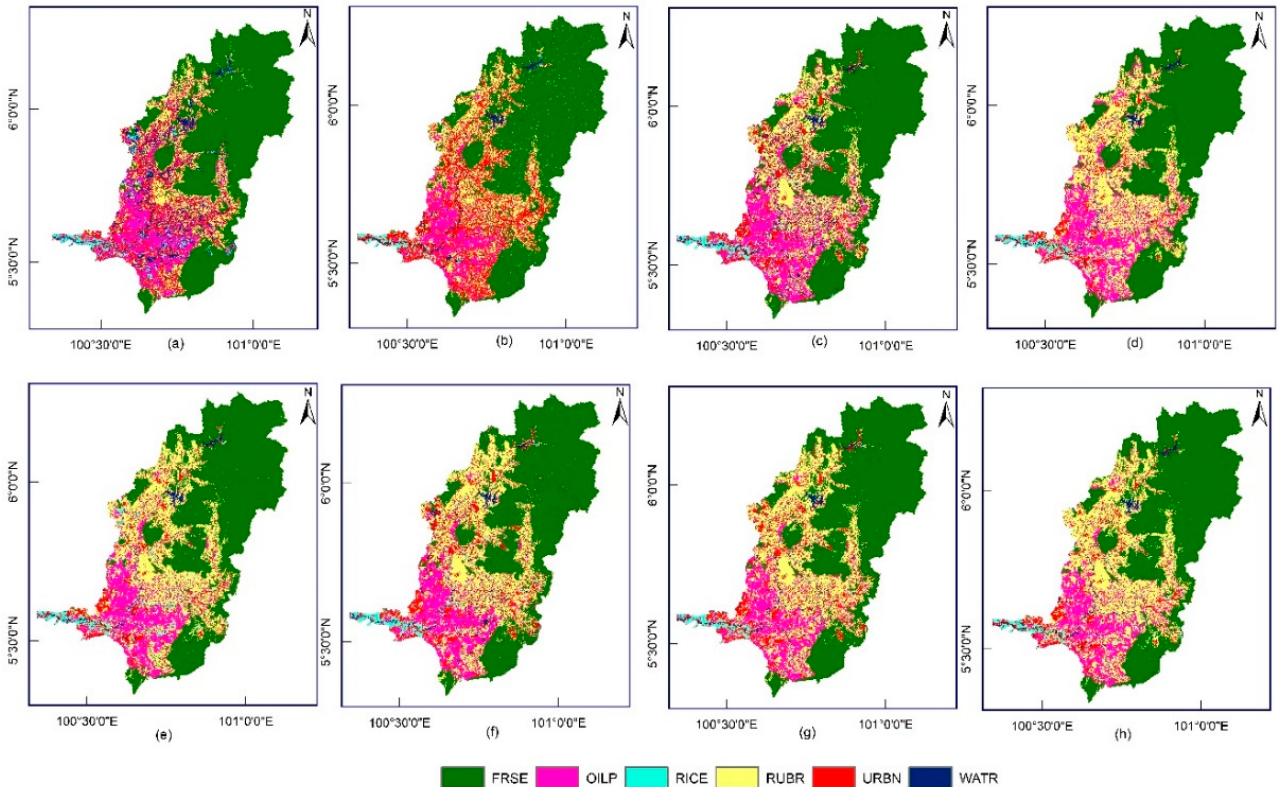
Figure 7. The 2020 MRB land use–land cover map produced from the combinations of ( a ) C1, ( b ) C2, ( c ) C3, ( d ) C4, ( e ) C5, ( f ) C6, ( g ) C7, and ( h ) C8.